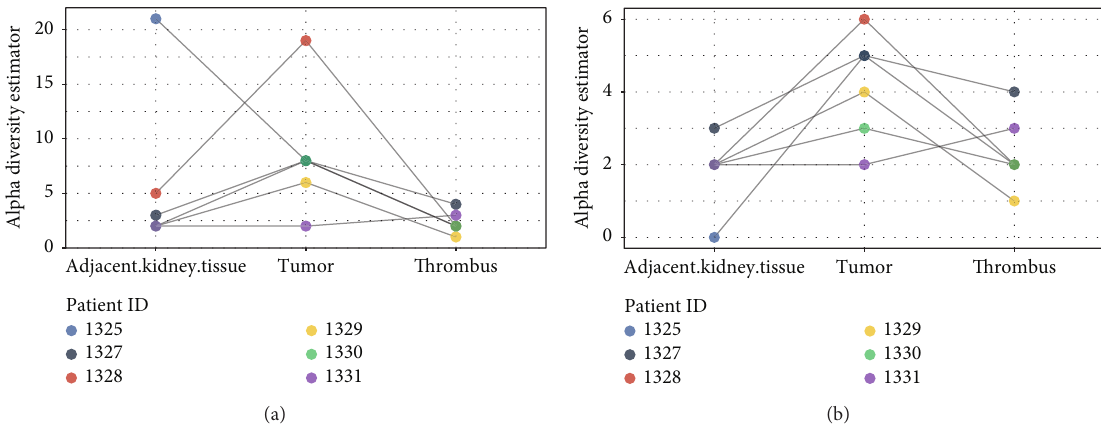
Figure 2: Alpha diversity analysis between locations. (a) shows alpha diversity with an abundance of > 1% using an alpha diversity estimator as the comparator. In (b), we display the alpha diversity with an abundance of > 5%.